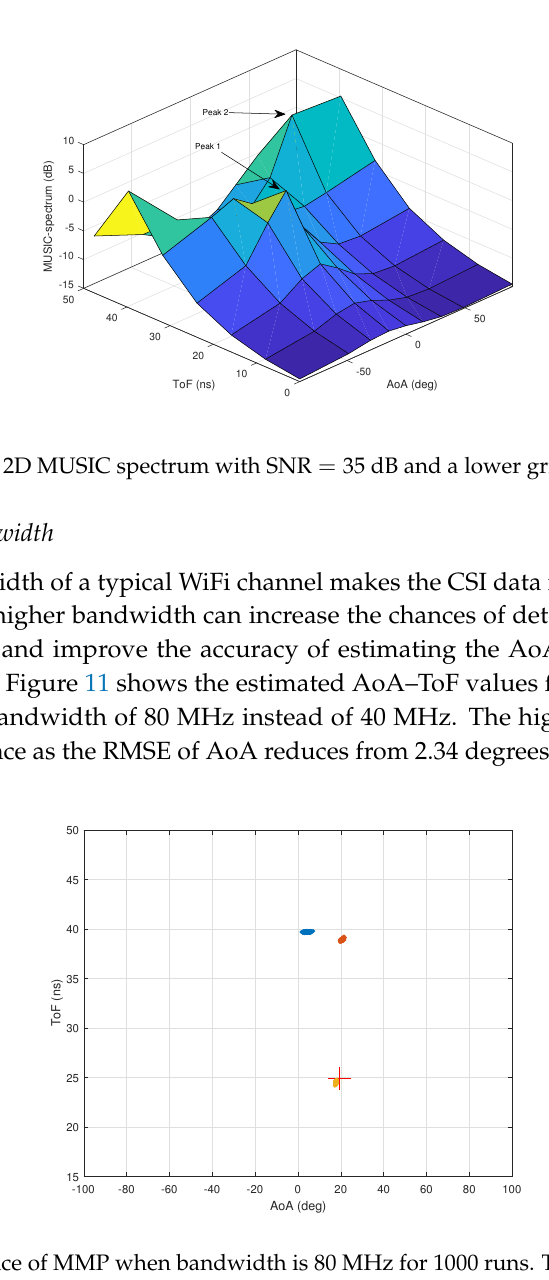
Figure 11. Performance of MMP when bandwidth is 80 MHz for 1000 runs. The RMSEs for AoA and ToF are 1.80 deg and 0.44 ns. Simulation time is 0.80